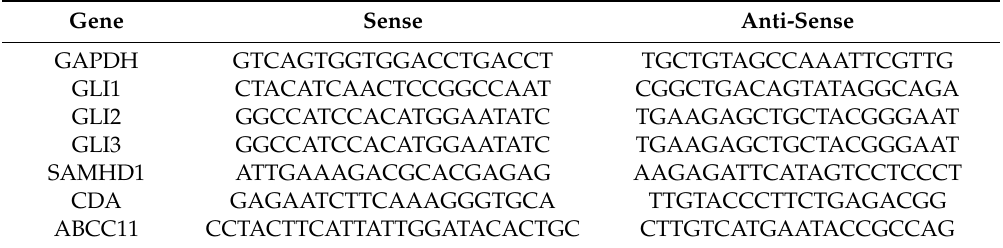
Table A1. Primers used in this